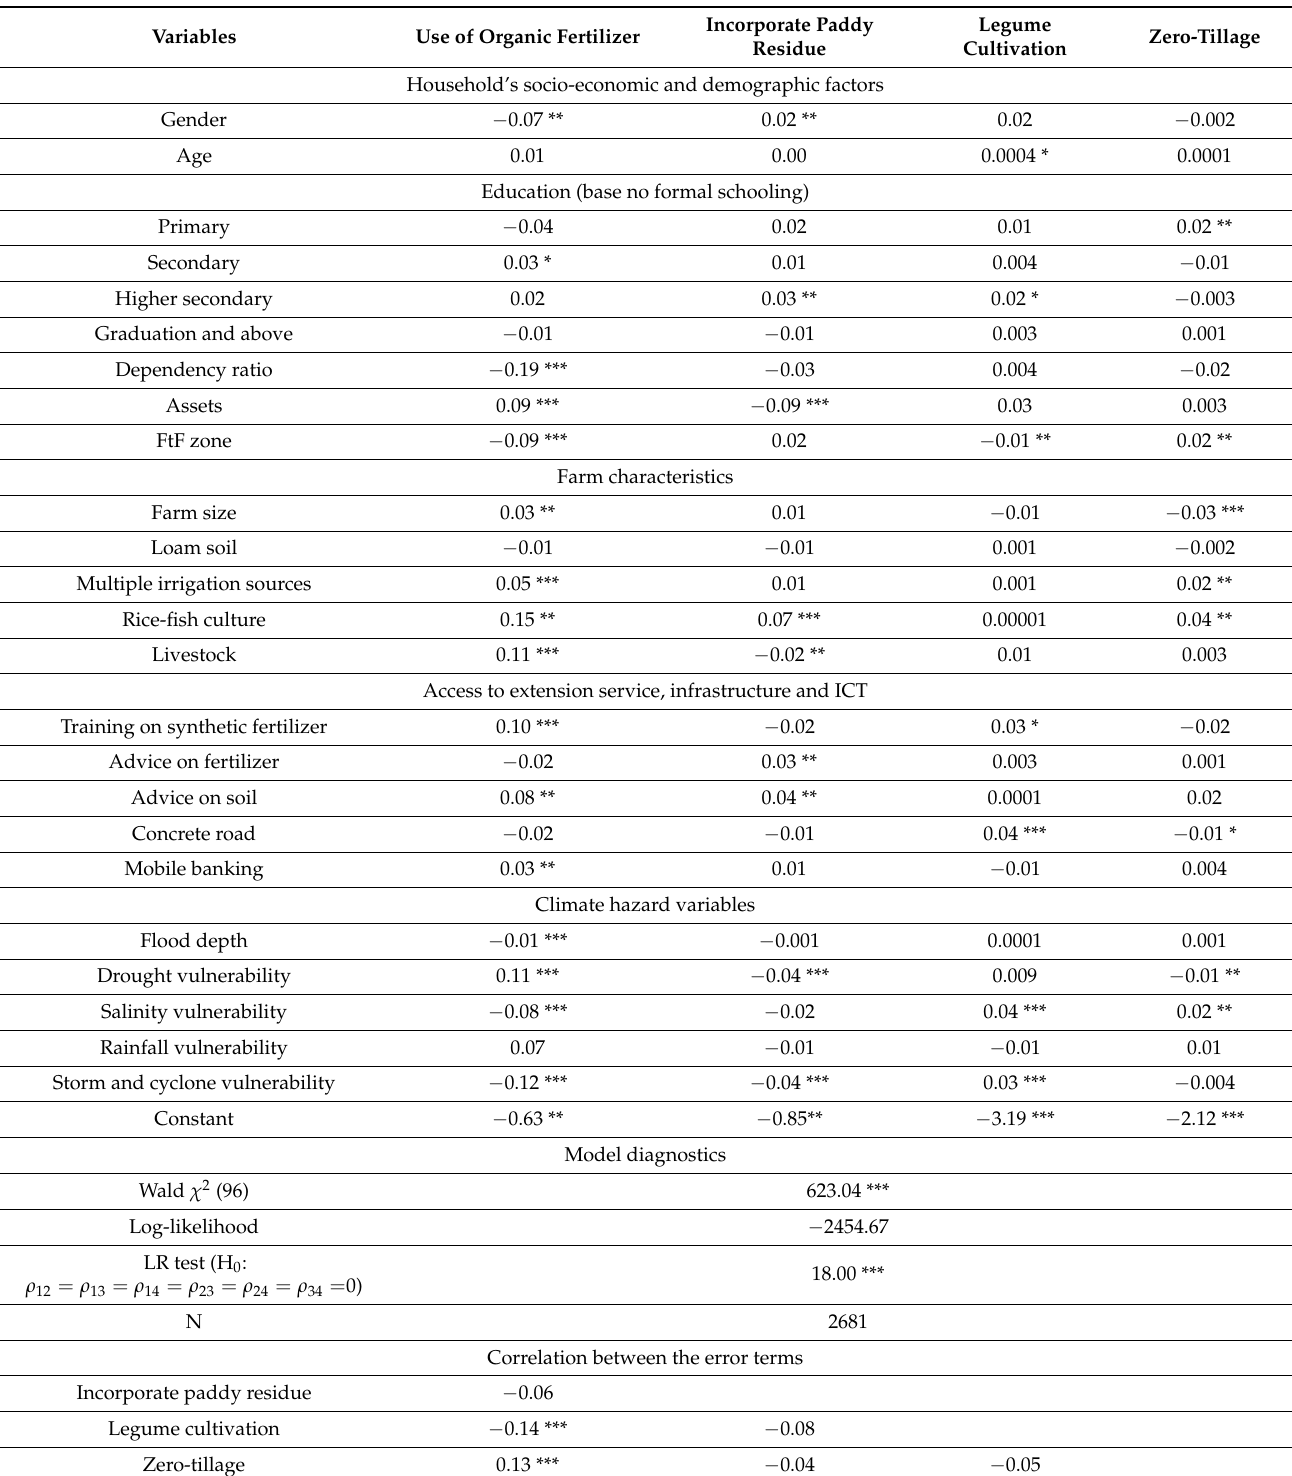
Table 4. Marginal effects of the variables used in explaining adoption of sustainable soil management practices and synergies among the sustainable soil management practices (MVP